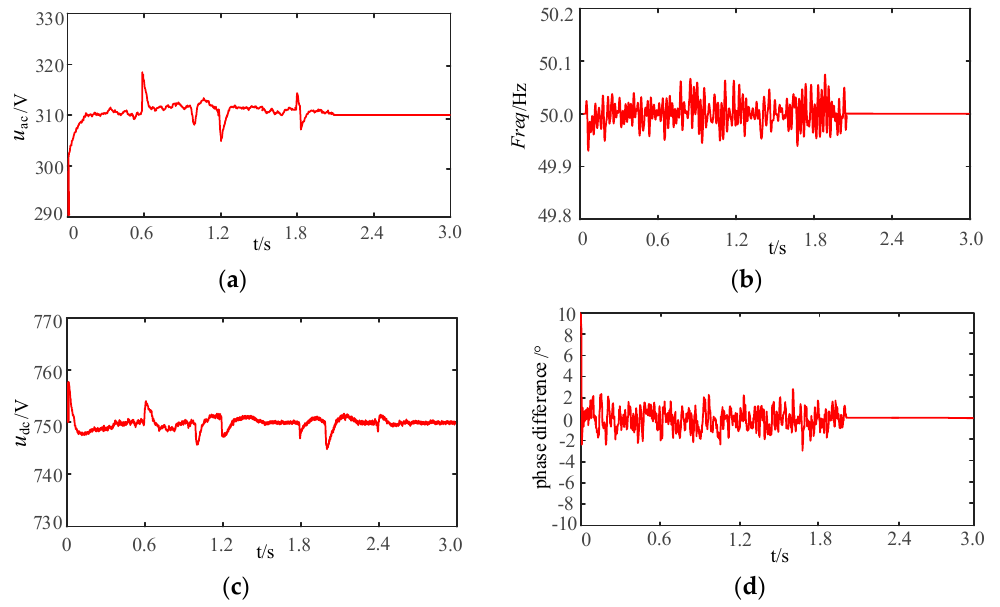
Figure 13. Parameter characteristics of the energy router in case 2: ( a ) AC bus phase voltage amplitude;